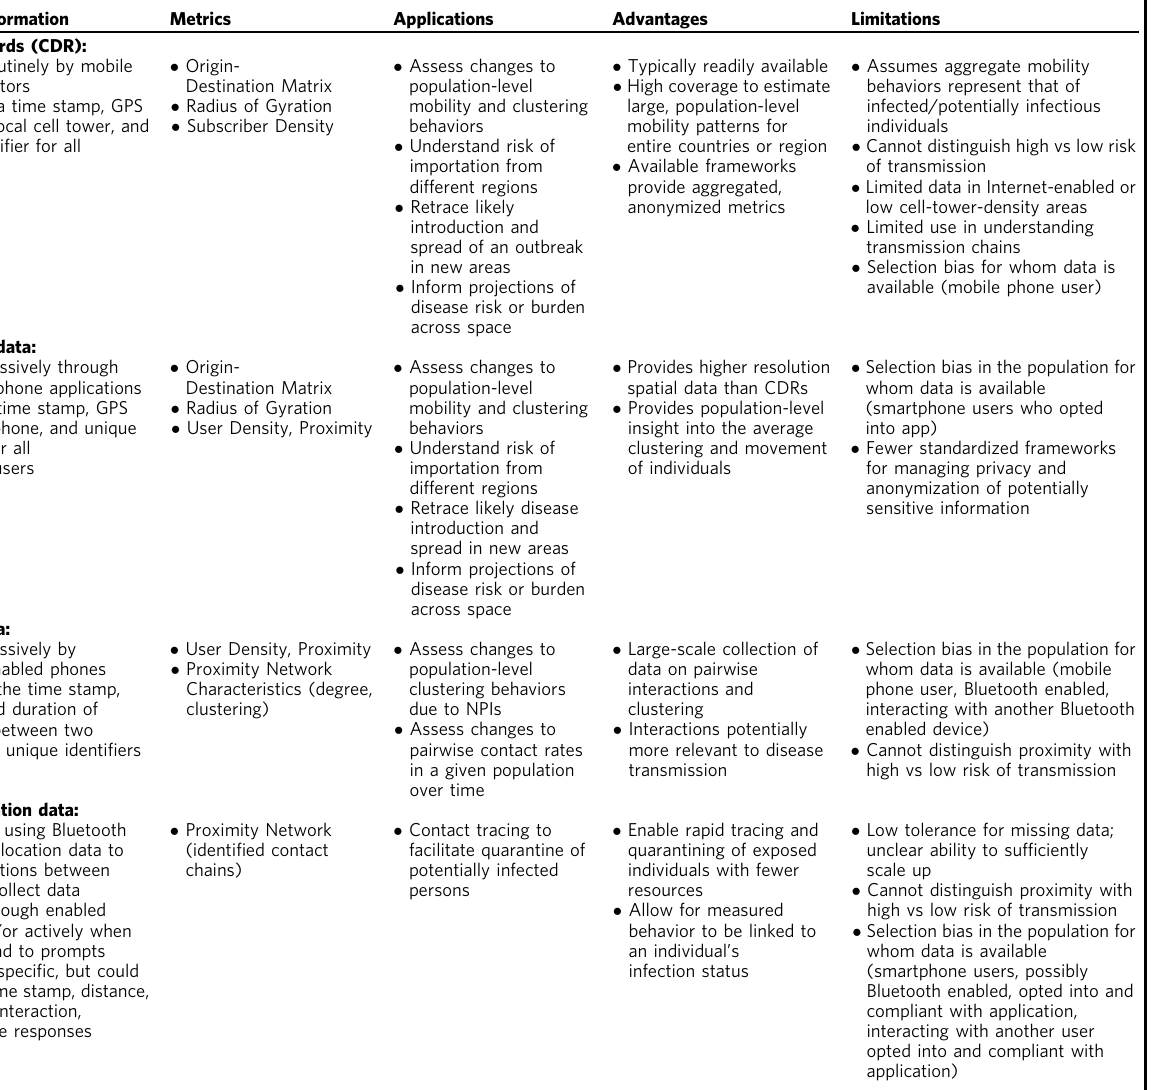
Table 1 Summary of types, metrics, and proposed applications of mobile phone data. Data